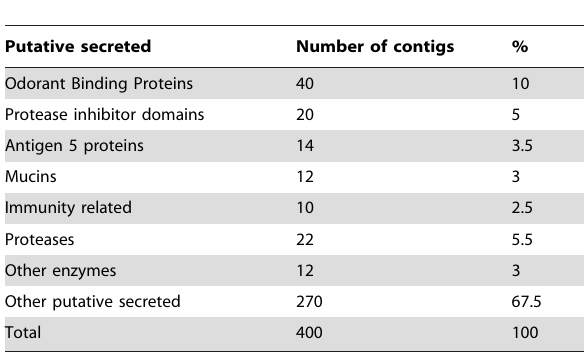
Table 3. Classification of TAG peptides with putative secretory